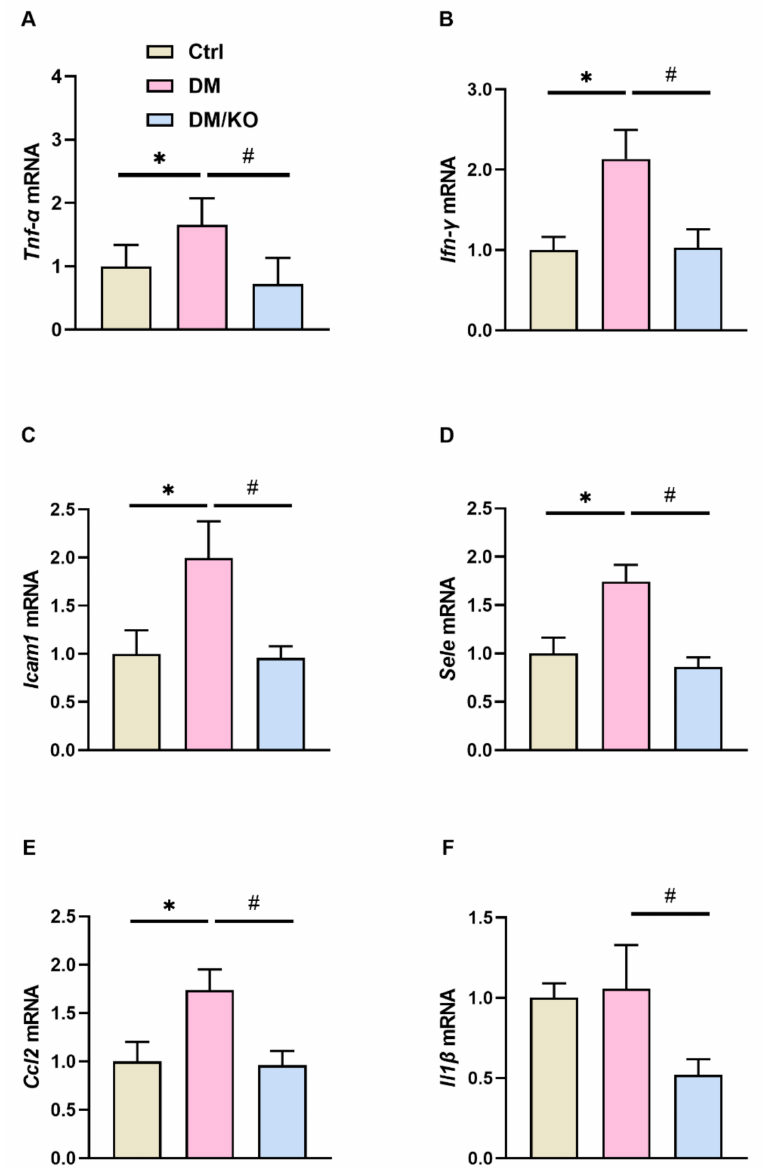
Figure 4. KO ameliorated the DM-promoted proinflammatory gene transcription. Cardiac mRNA expression of ( A ) Tnf- α , ( B ) Ifn- γ , ( C ) Icam1 , ( D ) Sele , ( E ) Ccl2 , and ( F ) Il-1 β were determined by qRT- PCR. Rplp0 was used as an endogenous control. The data were normalized to Ctrl and summarized as means ± SD. *, p < 0.05 vs. Ctrl; #, p < 0.05 vs. DM. Abbreviations: Ccl2 , C–C motif